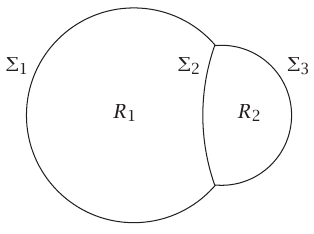
Figure 2.1 . Construction of a standard double bubble from three spherical caps.